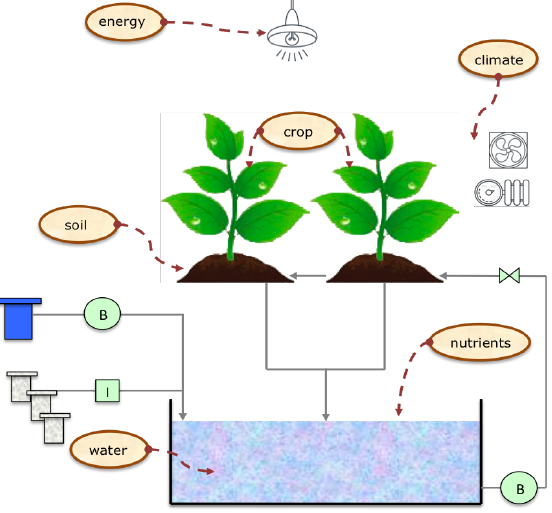
Figure 1. Agricultural Production